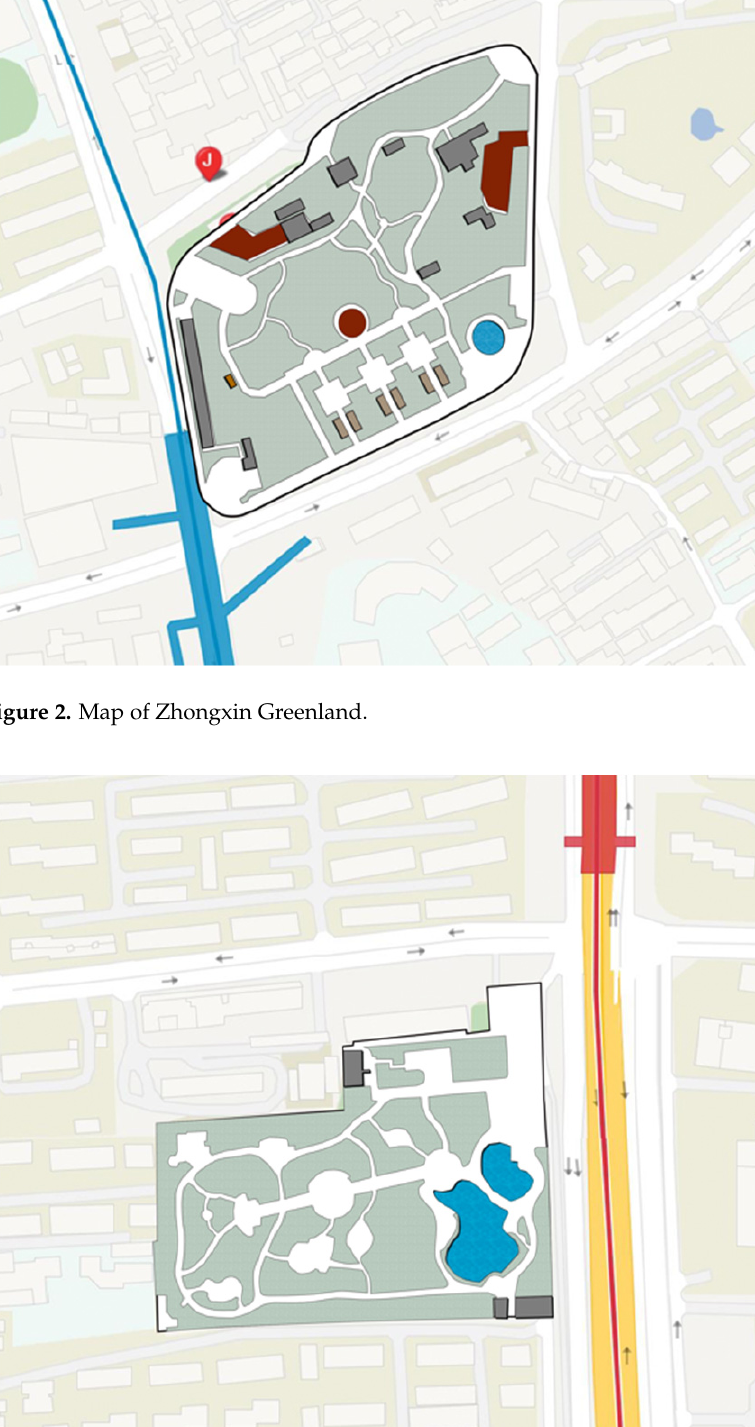
Figure 4. Map of Lingnan Park.